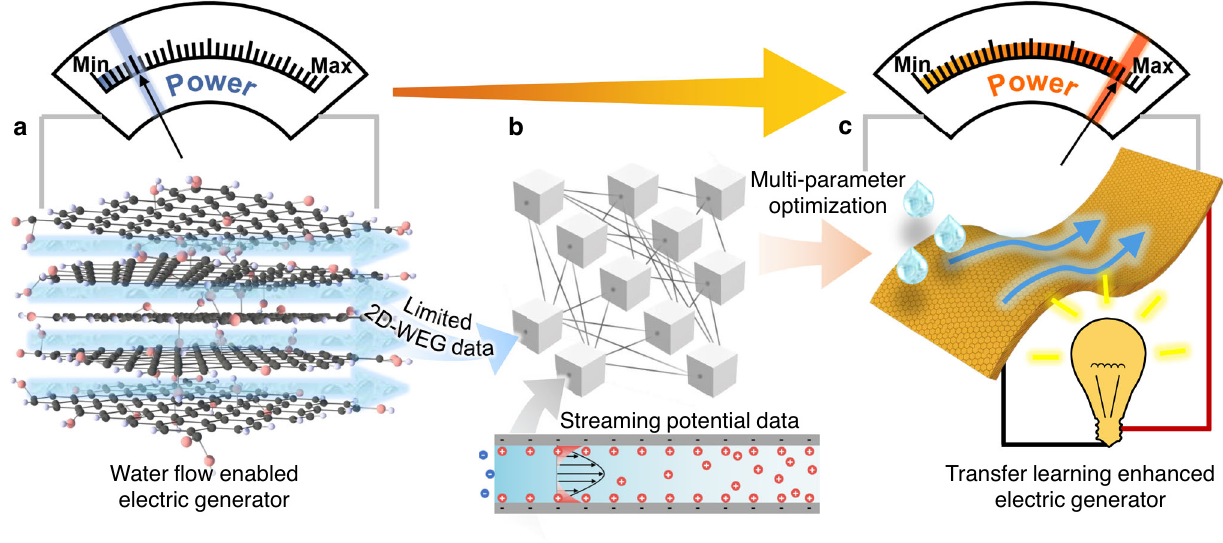
Fig.1|TLenhanced2D-WEGwithintegrated2Dchannels.a A2D-WEGbasedon the GO assembled framework with massive integrated 2D channels can generate considerableelectricenergybythespontaneousinternalwater fl ow. b Tosolvethe multi-parameterscouplingoptimizationproblemofthedeveloped2D-WEG,theTL framework is implemented to achieve accurate prediction and optimization of